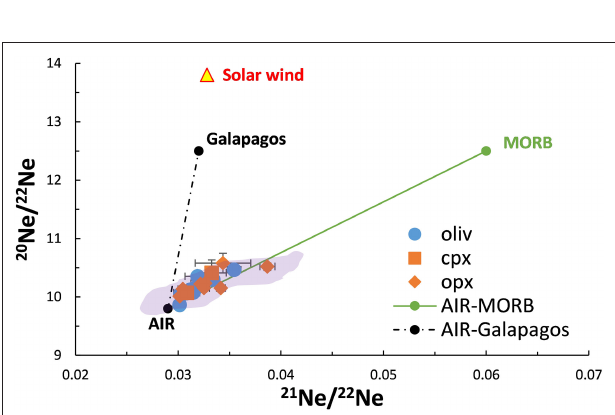
FIGURE 5 | Diagram of 21 Ne/ 22 Ne vs. 20 Ne/ 22 Ne. The green line represents binary mixing between air and a MORB mantle as defined by Sarda et al. (1988) and Moreira et al. (1998) at 21 Ne/ 22 Ne = 0.06 and 20 Ne/ 22 Ne = 12.5. The black dotted line indicates binary mixing between air and the OIB domain of the Galapagos Islands as determined by Kurz et al. (2009) at 21 Ne/ 22 Ne = 0.032 and 20 Ne/ 22 Ne = 12.5. The primordial neon composition is also reported as Solar wind (e.g., Heber et al., 2009), with at 21 Ne/ 22 Ne = 0.0328 and 20 Ne/ 22 Ne = 13.8. The violet area indicates data from other European localities (French Massif Central, Eifel, and Pannonian Basin) measured by Gautheron et al.